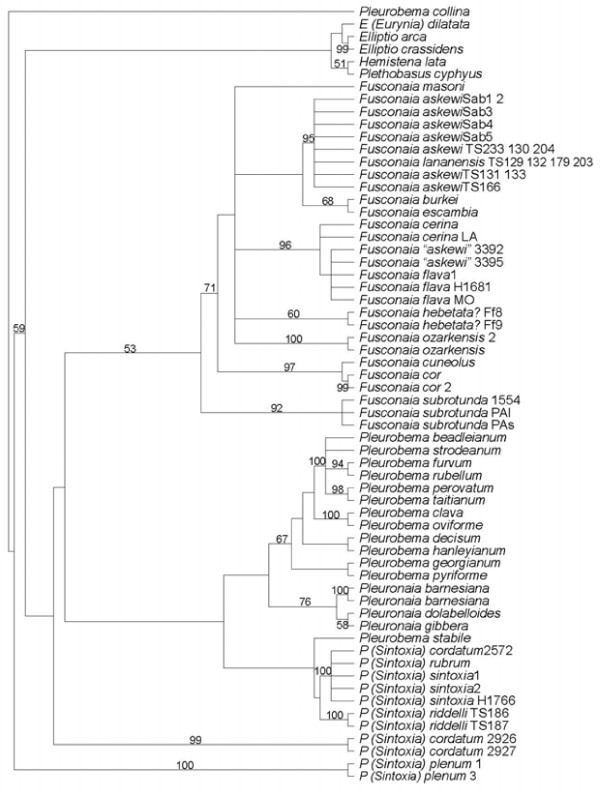
Strict consensus cladogram,cox1data, with jackknife percentages shown if over 50%.